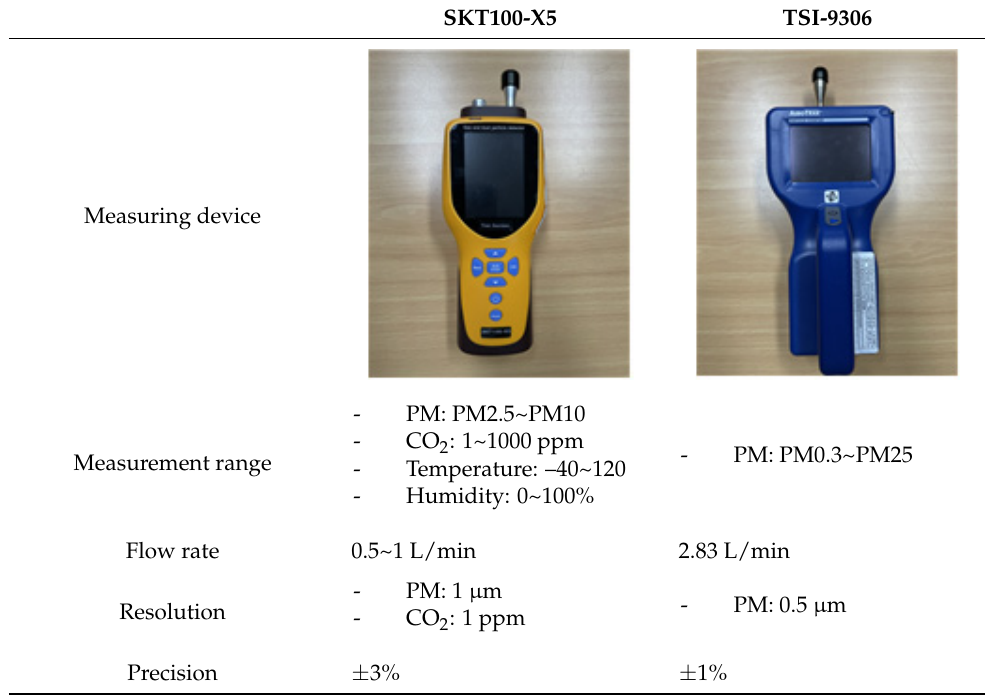
Table 4. Analysis of the error rate between the CSM and precision measuring devices.